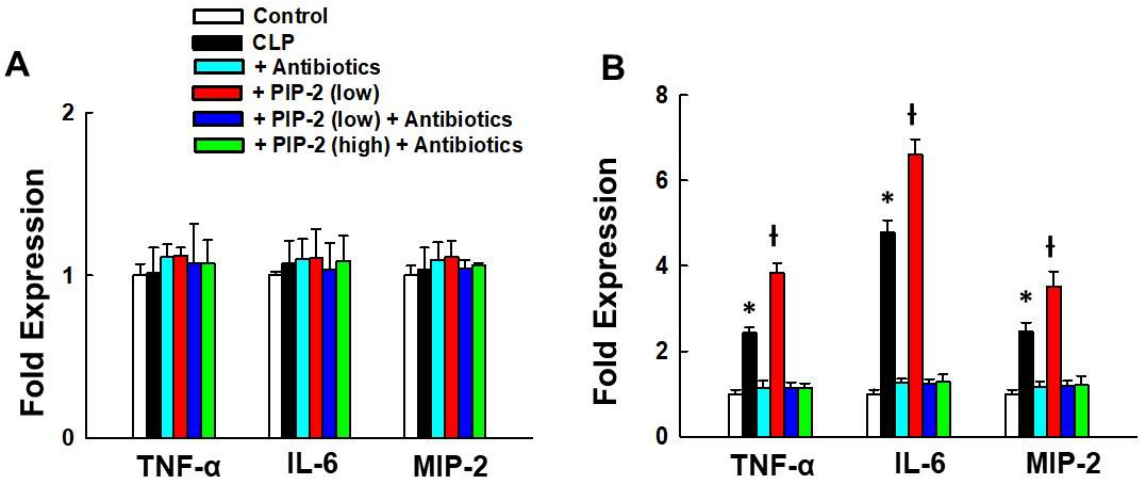
Figure 2. Effect of PIP-2 and/or antibiotics on cytokine expression in lung. Expression of cytokines is expressed as fold change (control = 1) in lung homogenate at 6 h or 24 h after generation of CLP. PIP-2 and /or antibiotics were administered at zero time (A) or at 6 h after surgery (B) ; lungs were harvested at 6 h (A) or 24 h (B) after surgery. Control was normal mice. PIP-2 low, 2 µ g/g body weight: PIP-2 high, 10 µ g/g body weight. A. mean + range for n = 2 for 6 h study; B. mean + SD for n = 4 for 24 h study. * p < 0.05 vs. all other conditions at 24 h, + p < 0.05 vs. all other conditions at 24h. Table 5. Oxidative injury measured at 6 h and 24 h after CLP.PIP-2 and /or antibiotics were administered at zero time (6 h) or at 6 h after surgery (24 h). TBAR 8-Isoprostanes Protein Carbonyls Spmol/mg Prot. pmol/mg Prot. nmol/mg